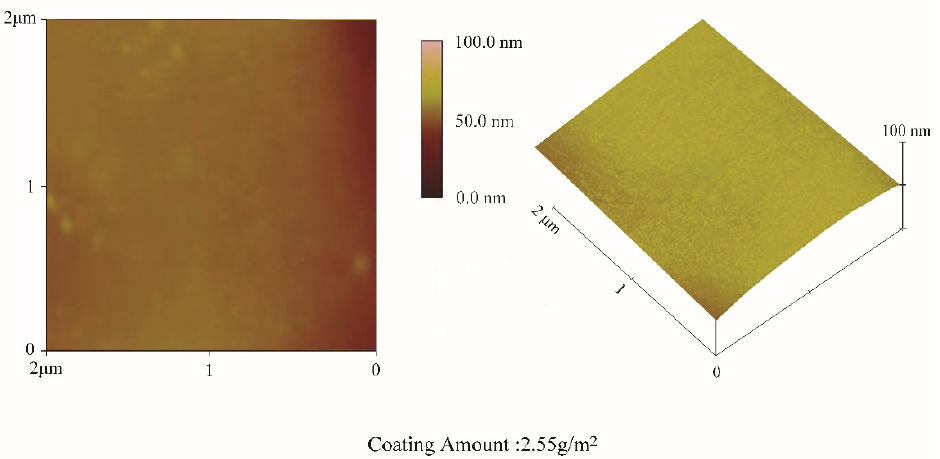
Coatings 2022 , 12 , x FOR PEER REVIEW 16 of 22